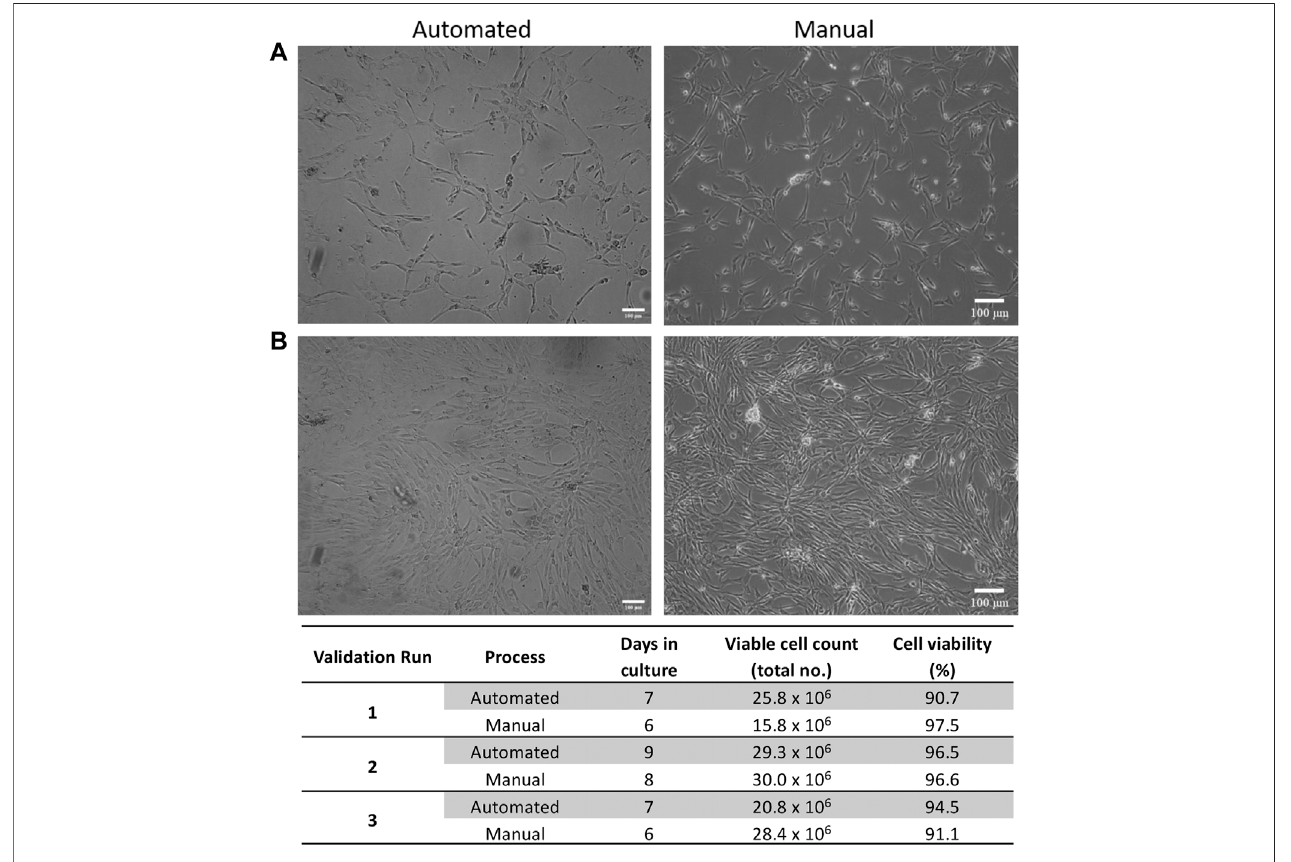
FIGURE 3 | Expansion characteristics of ASCs. Representative phase contrast images of cell morphology at (A) 50% and (B) 90% con fl uency respectively for automated and manual processes. (C) Expansion characteristics of cells from automated and manual processes for each validation run. Scale bar = 100µm.